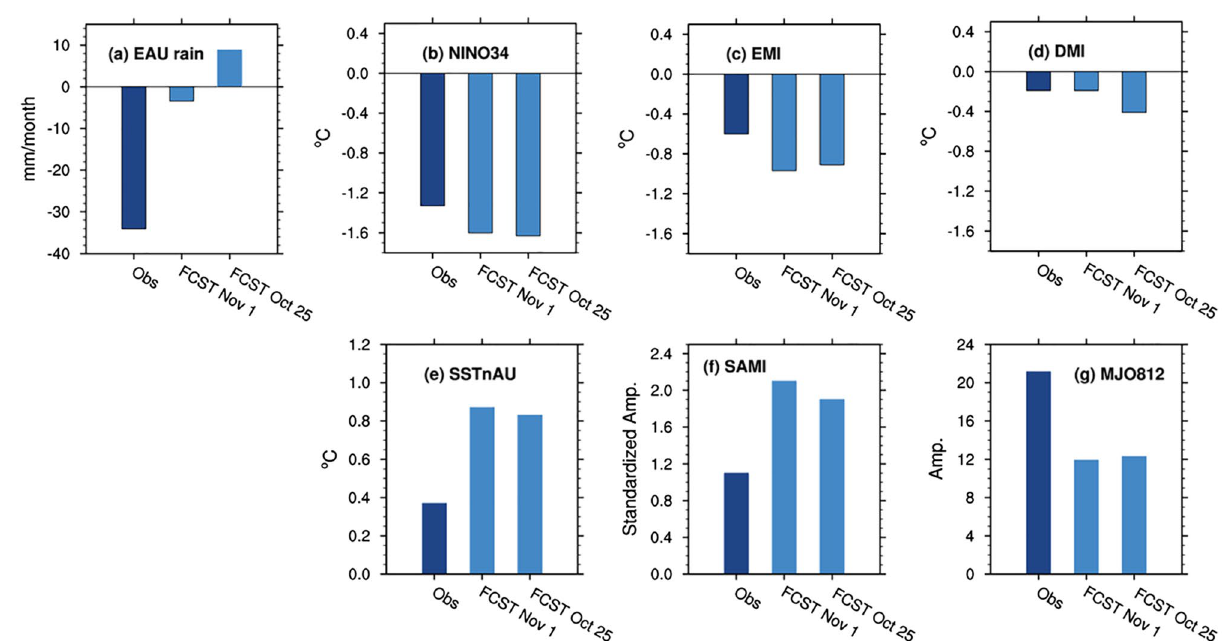
Figure 12. ACCESS-S1 forecasts initialised on 25 October and 1 November 2020 for eastern Australian rainfall and climate indices for November 2020. In ( g ) raw MJO812 (i.e., without removing its association with the Niño3.4 SSTs) is displayed to simplify the comparison with the real-time